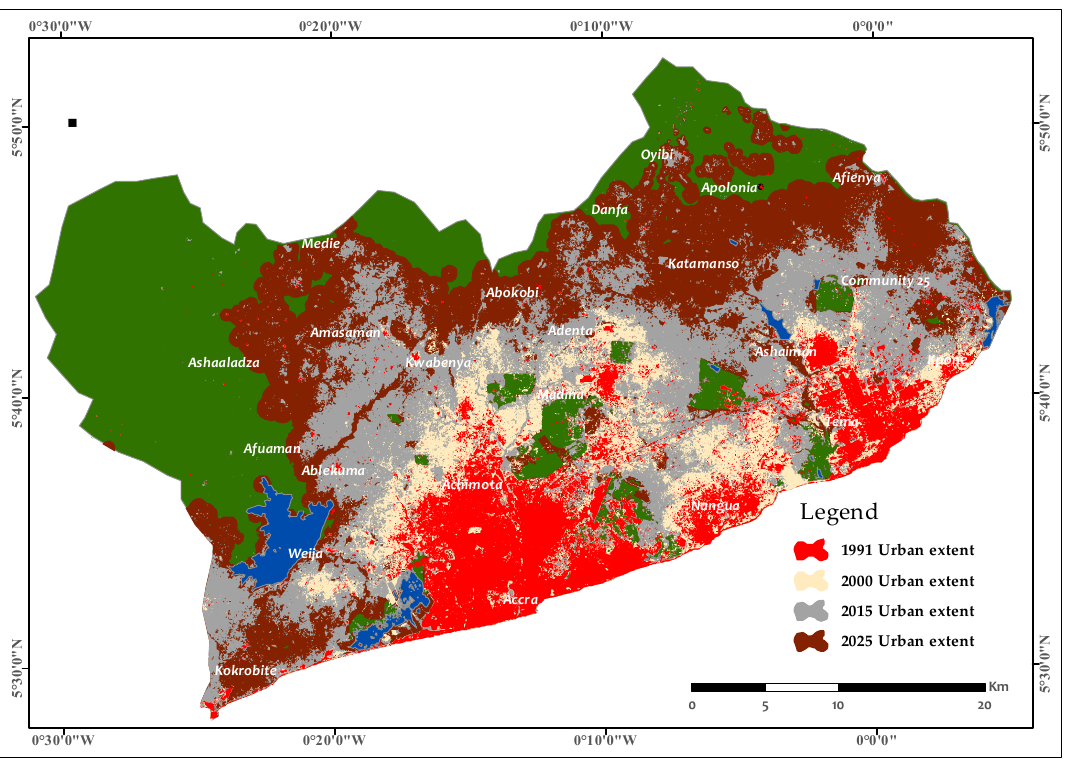
Figure 8. Changes in the urban extent of GAMA between 1991 and 2015 and the projected urban extent of the region for the year 2025.